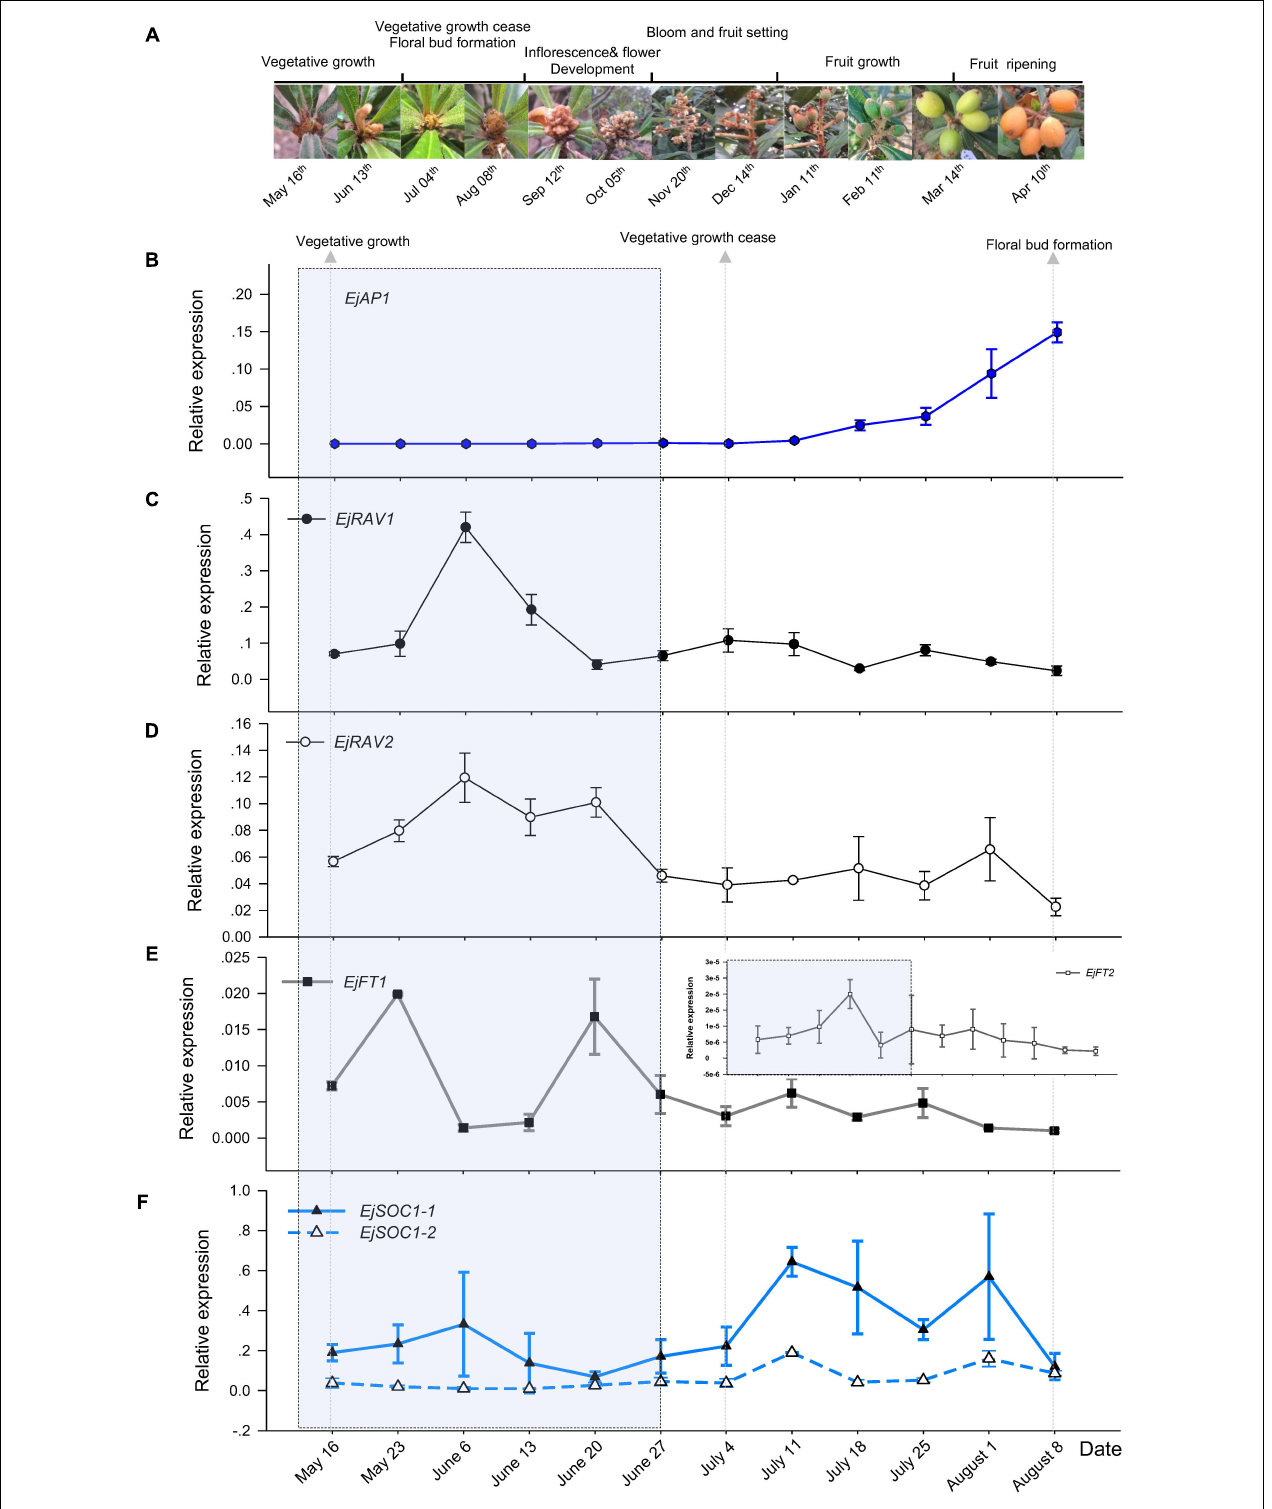
FIGURE 2 | Floral initiation and expressions of flowering regulating gene homologs in “Zaozhong-6” loquat. (A) Developmental changes in shoot apical meristem (SAM) of “Zaozhong-6” loquat from May 2018 to April 2019. (B–F) Expression patterns of EjAP1 (B) , EjRAV1 (C) , EjRAV2 (D) , EjFT1/2 (E) , and EjSOC1-1/2 (F) during floral initiation and early inflorescence development. EjAP1 was detected in SAM, while other genes were detected in mature leaves. The error bars represent standard deviation for three biological replicates. The light gray colored window indicates vegetative phase.